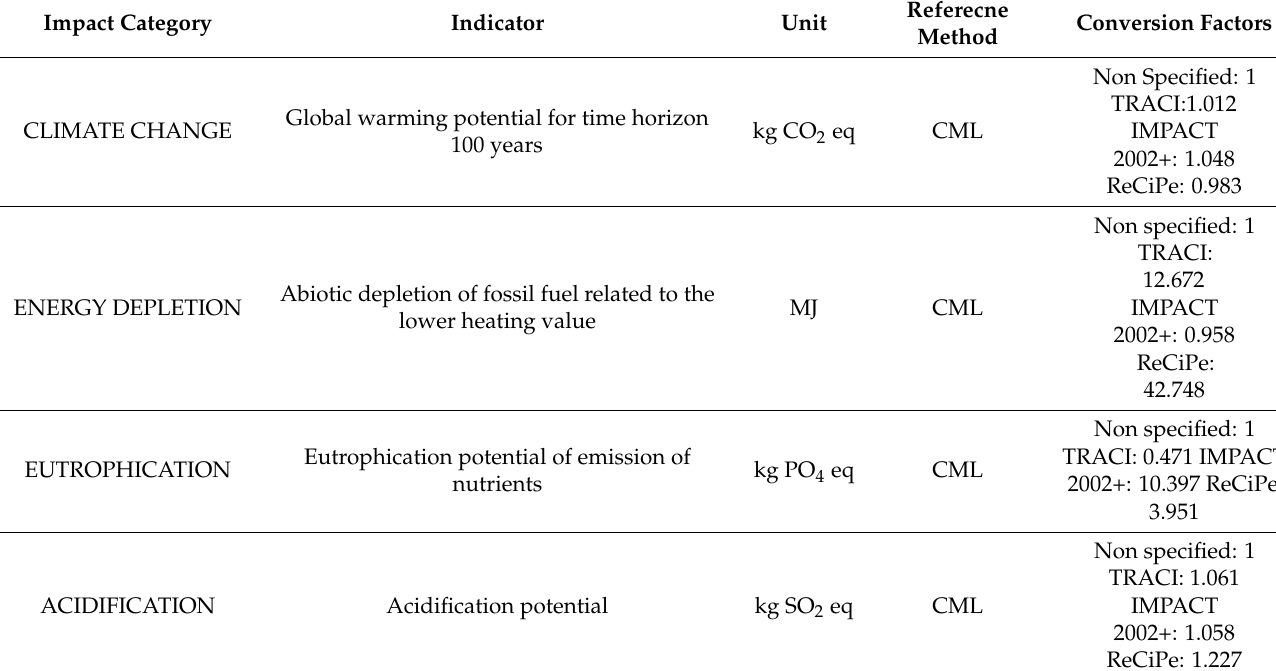
Table 2. Description of the impact categories and the conversion